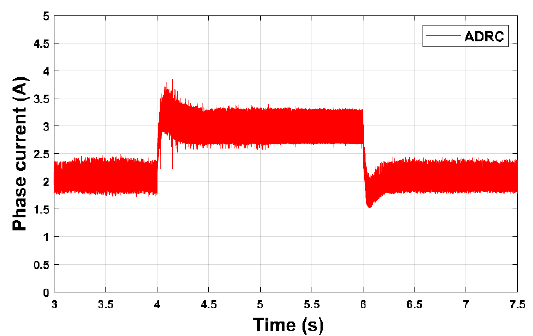
Figure 12. IHGBC phase current.